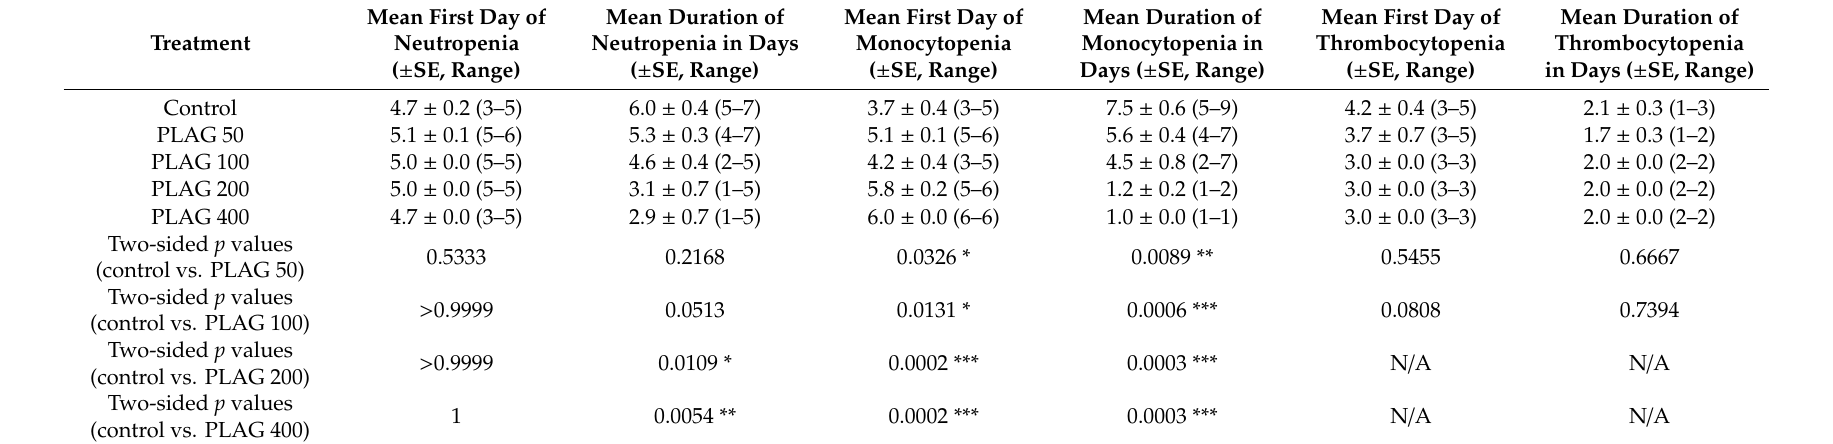
Table 1. The mean first day and mean duration of neutropenia (absolute neutrophil count (ANC) < 500 cells / µ L), monocytopenia (peripheral monocyte counts < 150 cells / µ L), and thrombocytopenia ( > 50% reduction from baseline) in control and 1-palmitoyl-2-linoleoyl-3-acetyl-rac-glycerol (PLAG)-treated mice injected with 5-Fluorouracil (5-FU) (100 mg / kg).